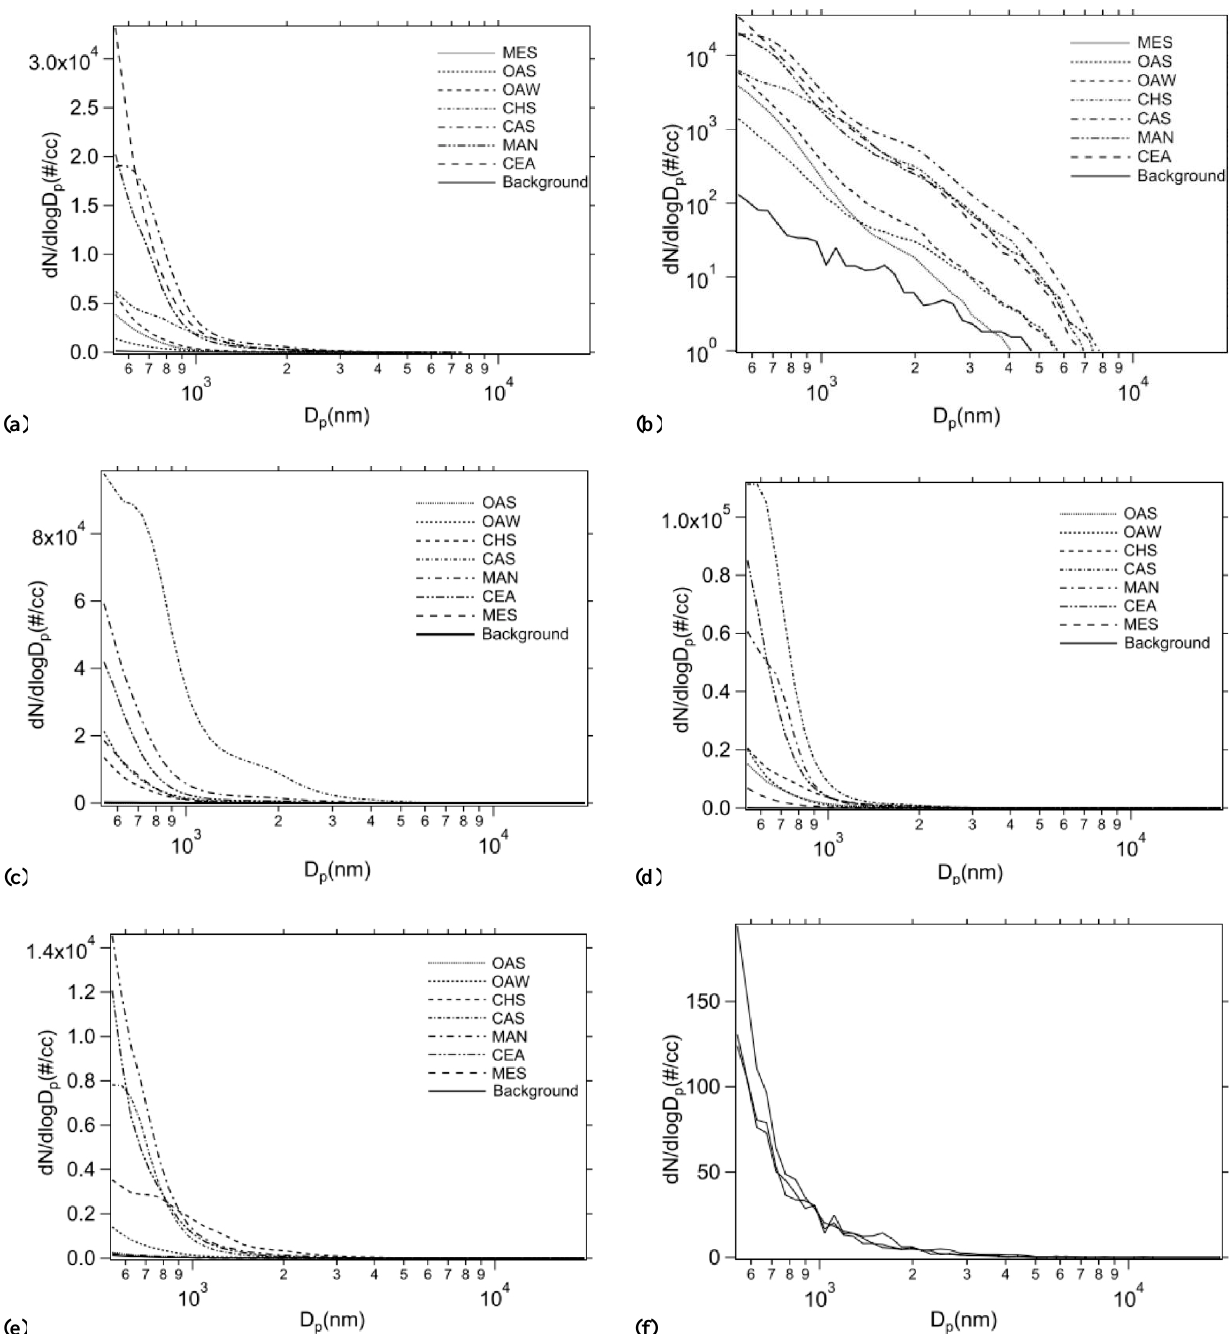
Fig. 5. Aerodynamic particle size distribution measured by APS for different phases (a) whole burn(linear) (b) whole burn(log-log) (c) Flaming (d) Mixed (e) Smoldering, and (f) corresponds to background